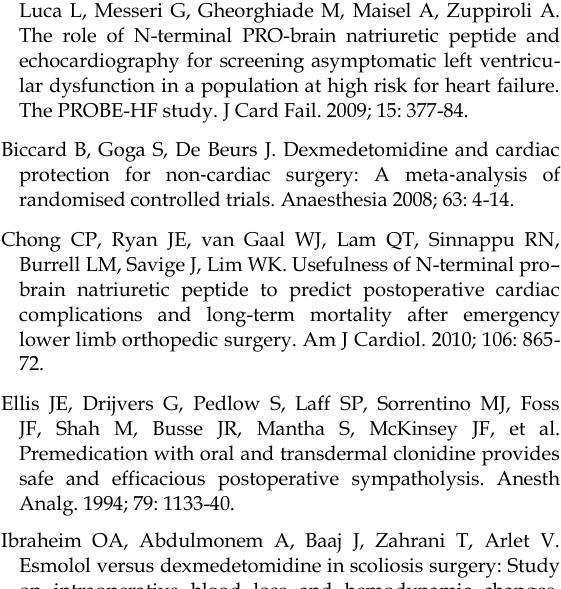
Placebo Figure 3: Mean pulse rate changes (MACE: Atrial fibrillation, flutter, acute heart failure, or non-fatal/fatal myocardial infarction) in patients undergoing elective prosthesis orthopedic surgery.